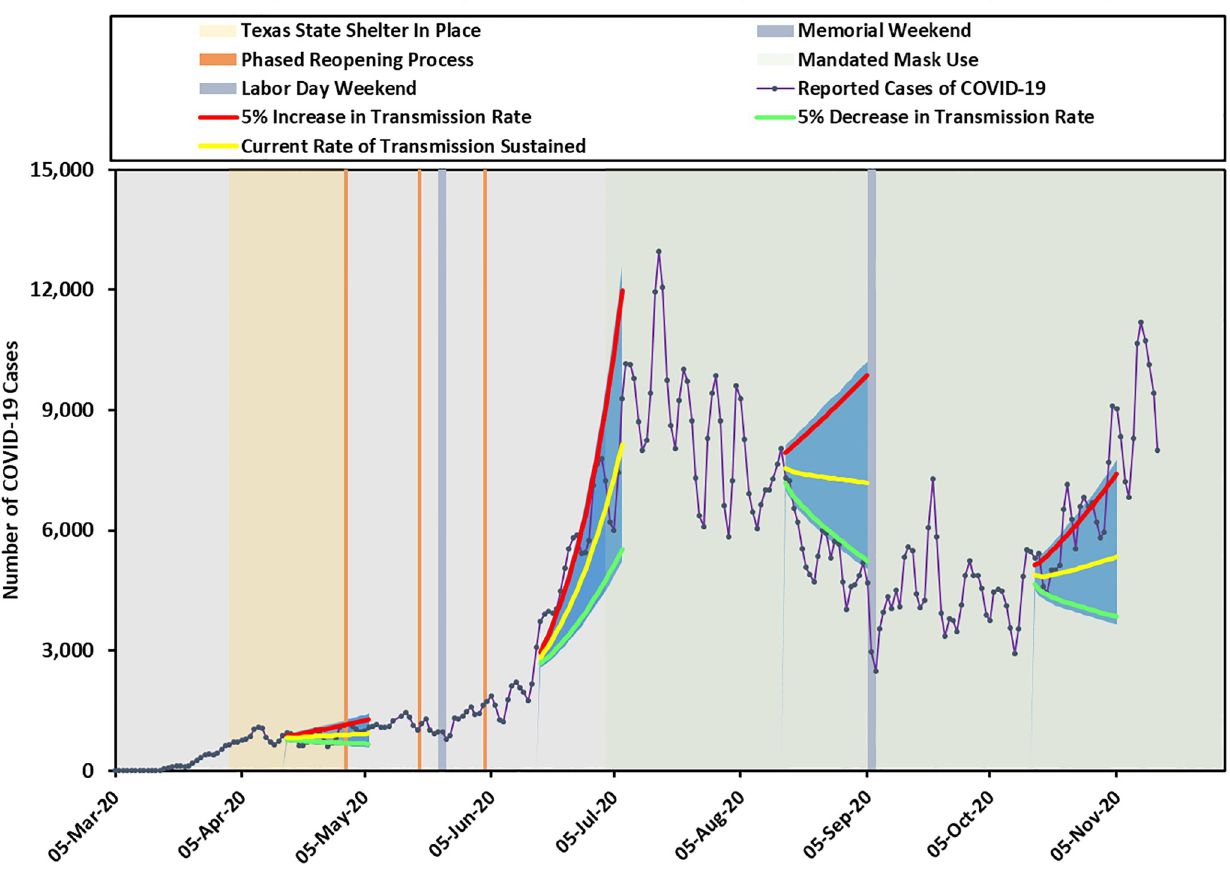
Fig 2. Texas predicted incidence cases using 7-day intervals. Three solid lines represent the predicted cases corresponding to current rate of transmission sustained, 5% increase in transmission rate, and 5% decrease in transmission rate. The shaded areas indicate prediction